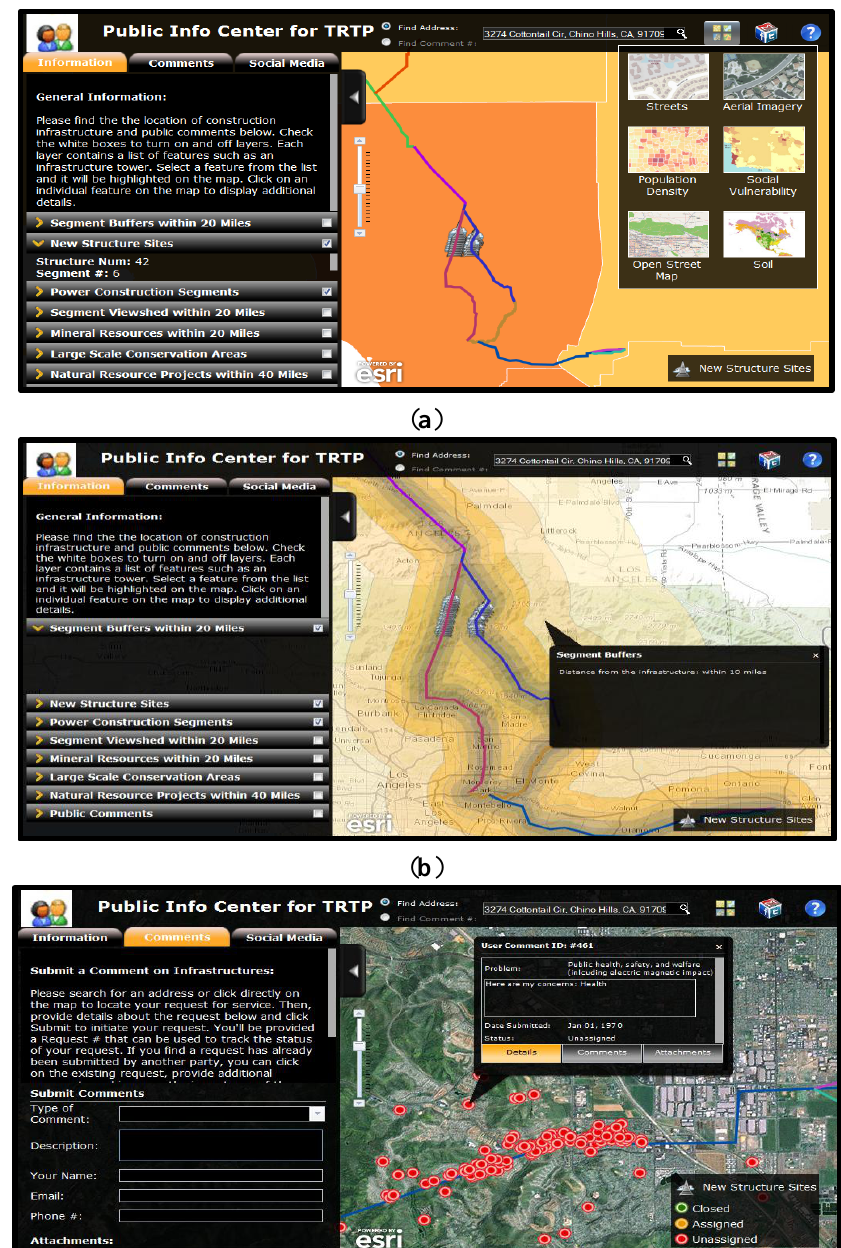
Figure 2. Examples of the five components in SIPPS. ( a ) Spatial component example: a public user can select a basemap (e.g., population density) from six options and review it with other Environmental Impact Assessment (EIA) project information; ( b ) analysis component example: a user can view multiple buffer rings on the map and click on a location within the buffer to find out the distance from proposed project activities; ( c ) comment component example: each red circle on the map represents a public comment; a user can click red circles to review the comments submitted by others; ( d ) comment component example: a user can submit a new comment with a picture attachment; ( e ) comment component example: relevant live feeds from YouTube, Twitter and Flickr are retrieved dynamically and displayed on the map; ( f ) mobile component example: a public user can review EIA project data and post comments using a mobile